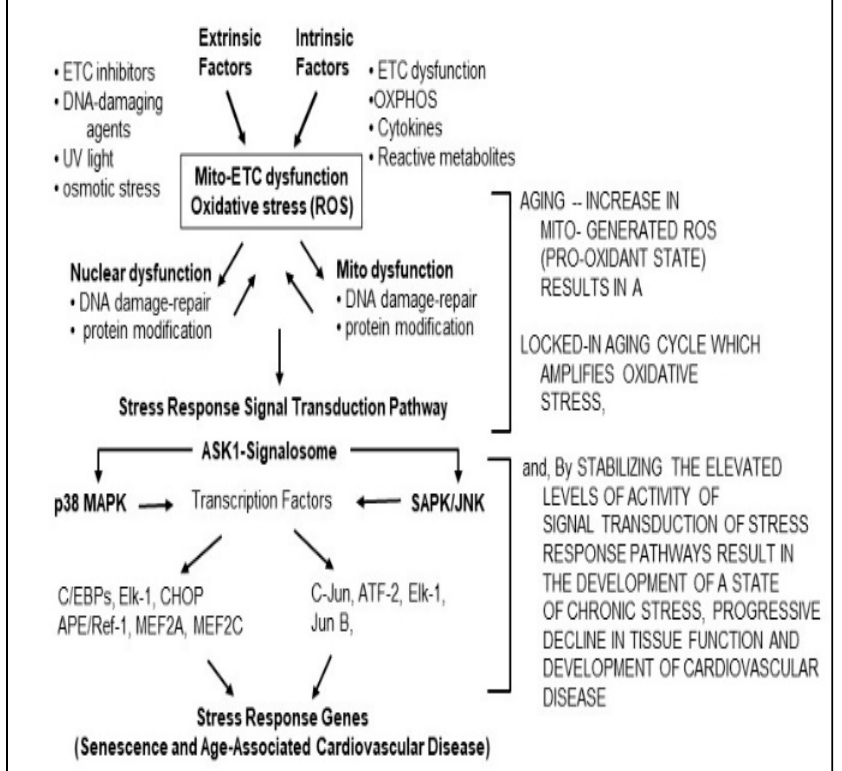
Figure 1. The oxidative stress chronic cycle of aging defines the epigenetic processes in development of the biochemical characteristics of senescence, aging and aging-associated diseases.